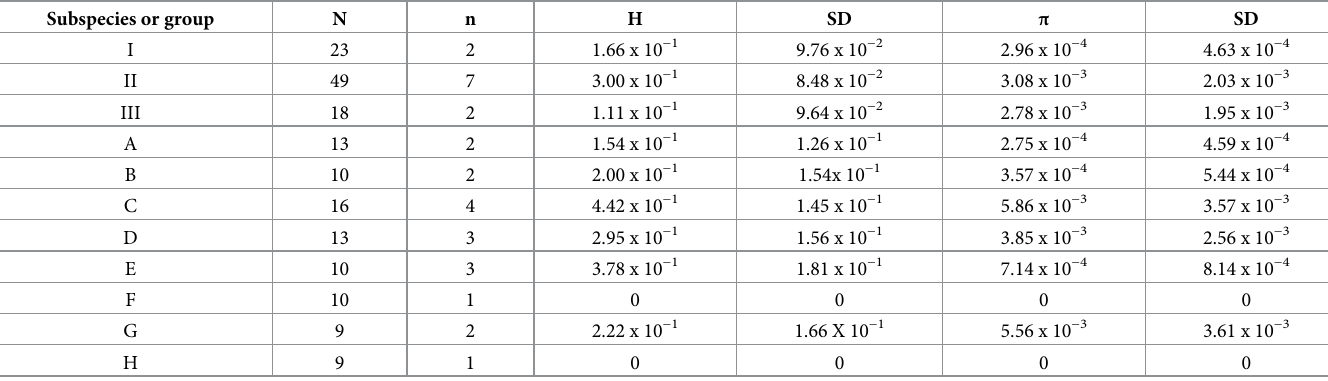
Table 1. Genetic diversity indexes for each subspecies and group.